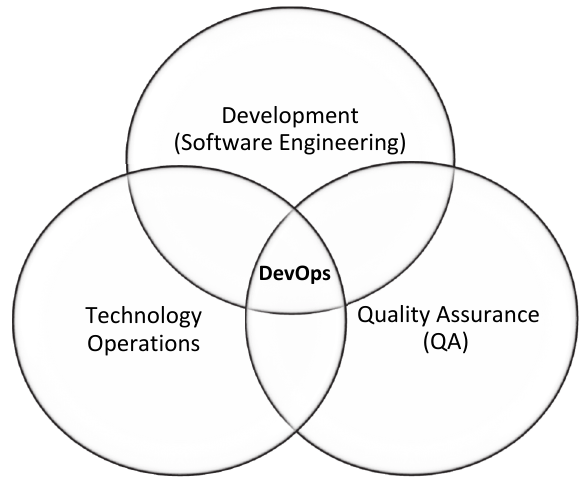
Fig. 3. Functionality of DevOps methodology.